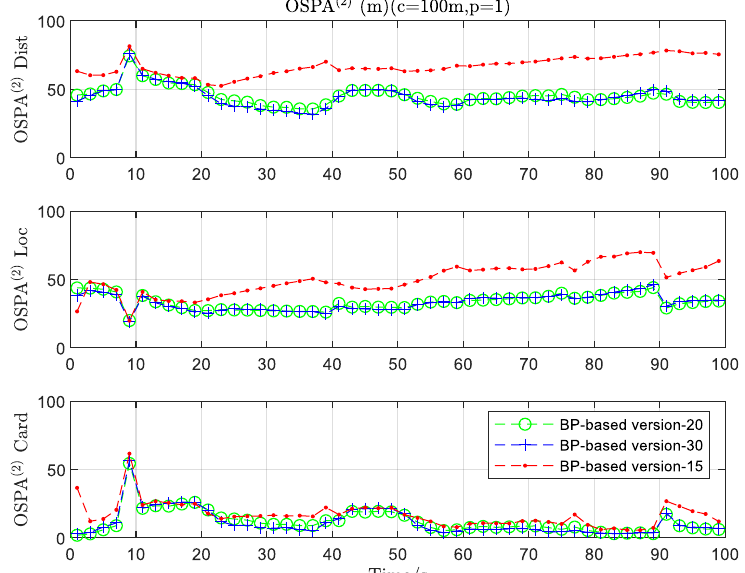
Figure 9. The OSPA (2) error of the BP-version for different iterative time.